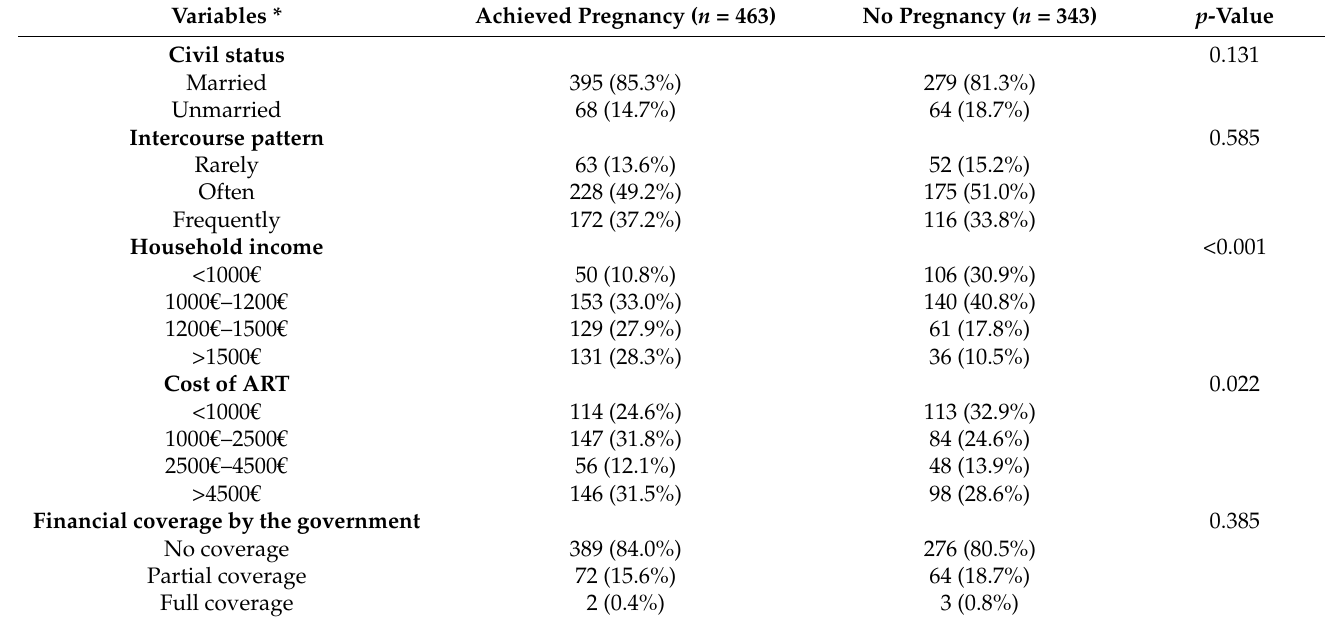
Table 2. Background and expenses faced by infertile couples attempting to achieve